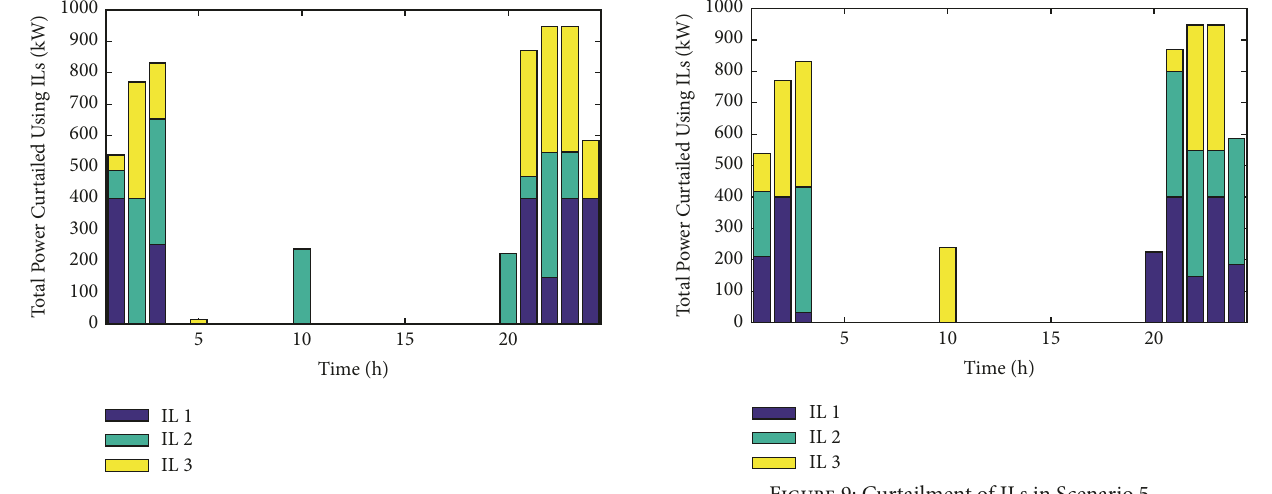
Figure 8: Curtailment of ILs in Scenario 4. Figure 9: Curtailment of ILs in Scenario